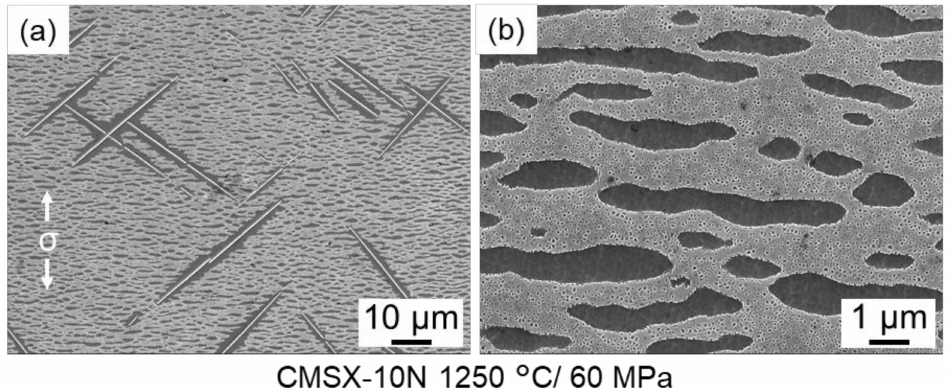
Figure 10. Microstructures at middle of CMSX-10N after creep test at 1250 ◦ C/60 MPa, interrupted at 31 h and 0.79% creep strain ( a ). ( b ) is magnified image of ( a ).